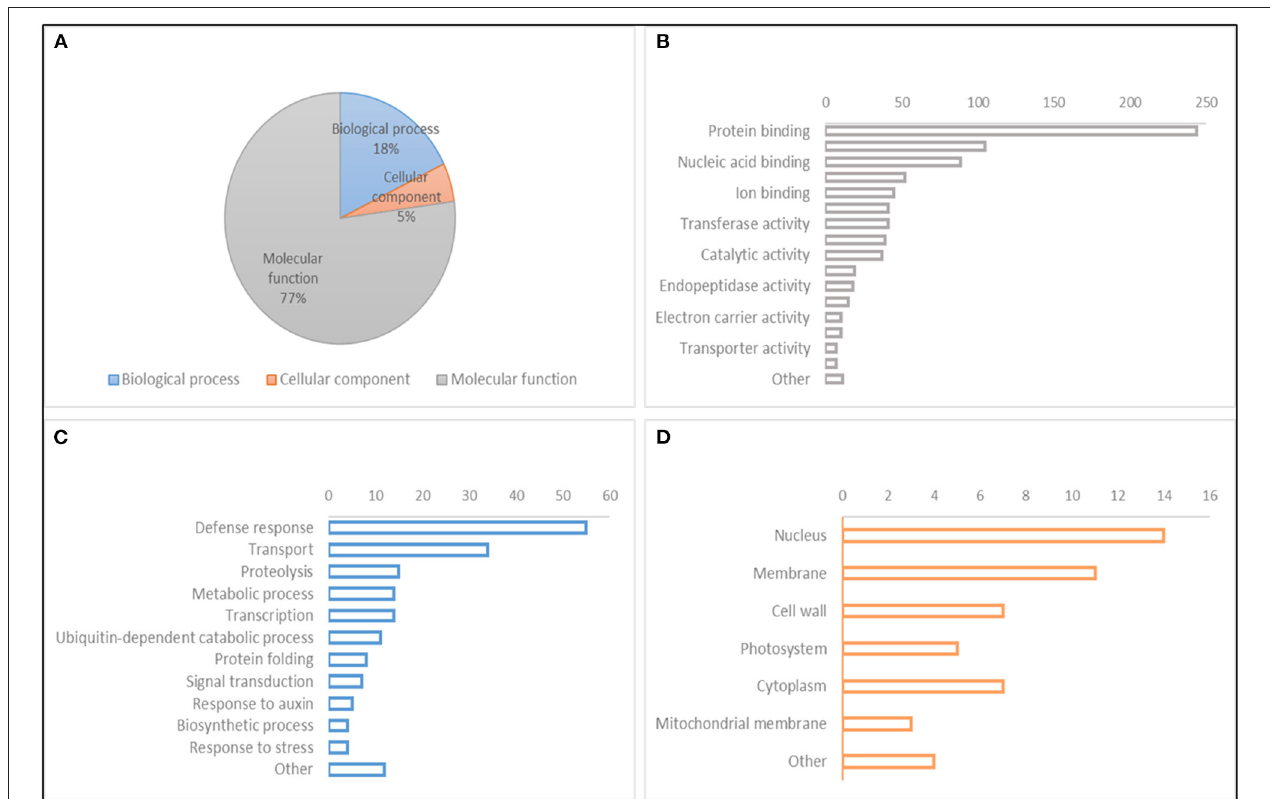
FIGURE 6 | Gene Ontology (GO) classification of gene models within QTL hotspots. (A) GO hierarchy. (B) Molecular function. (C) Biological process. (D) Cellular